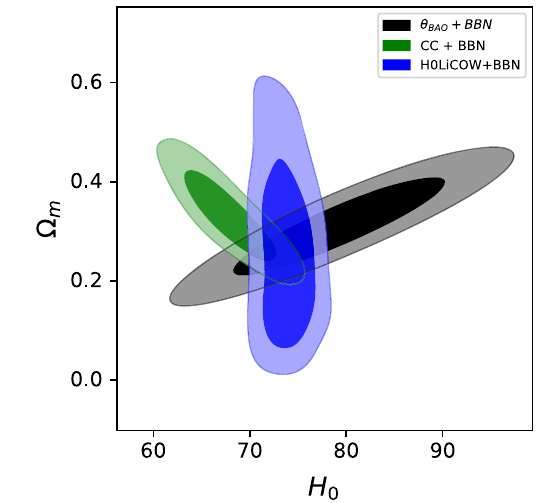
Fig. 5 Parametric space in the H 0 − (cid:3) m plane inferred from θ BAO + BBN, CC + BBN and H0LiCOW+BBN. The H 0 parameter is measured in units of km s − 1 Mpc −